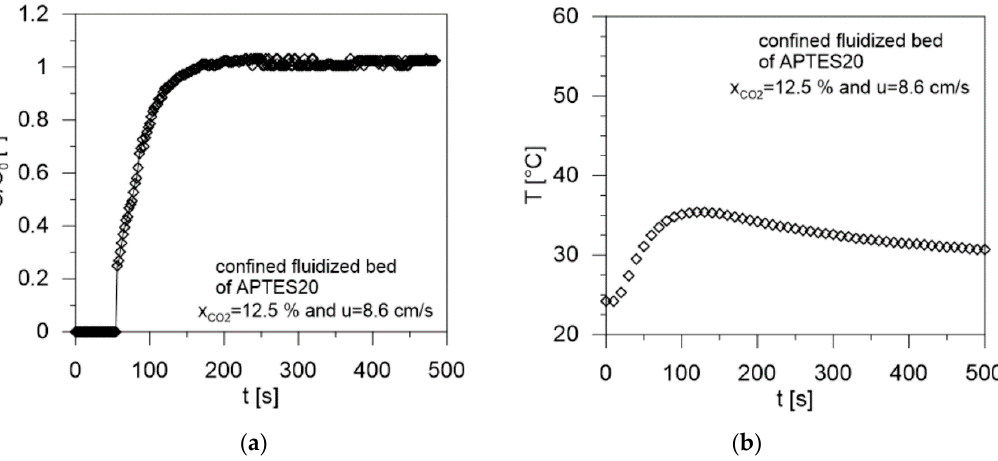
Figure 14. Adsorption test for APTES20 in a confined bed at u = 8.6 cm/s. Mass of adsorbent: 100 g. ( a ) Breakthrough curve; ( b ) temperature trend.